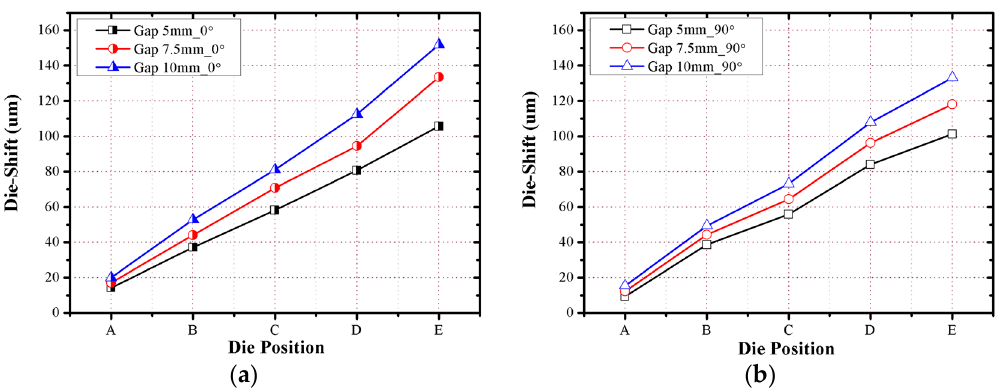
Figure 15. Die shift caused by EMC flow drag force: ( a ) 0° direction; ( b ) 90° direction.